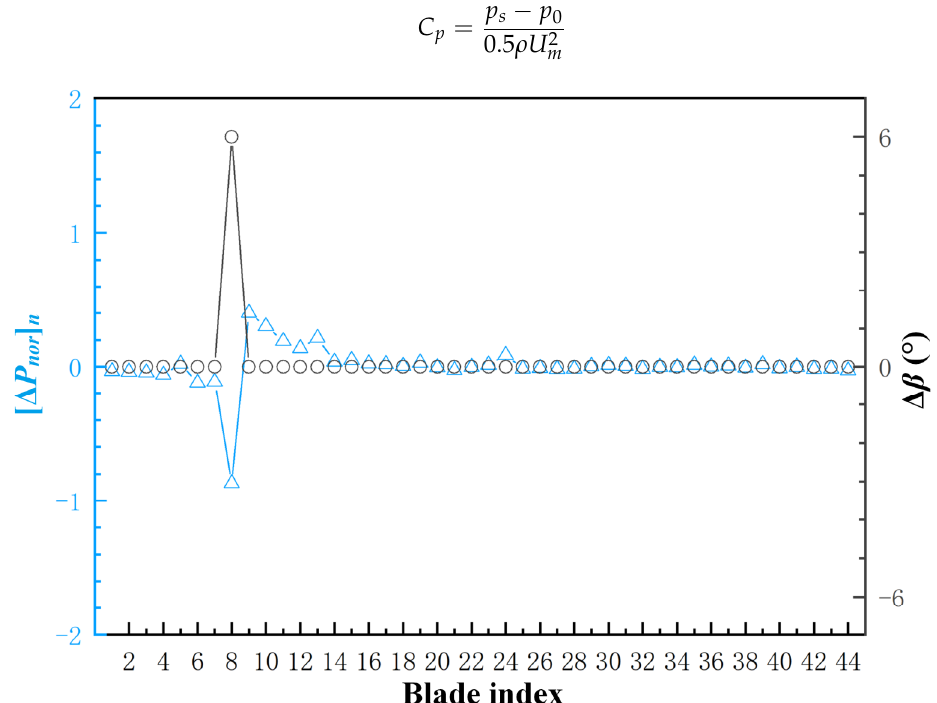
Figure 10 . Dimensionless load [∆  ]  and the change in stagger angle ∆β for Case 2 (Φ = 0.580). Figure 10. Dimensionless load [ ∆ P